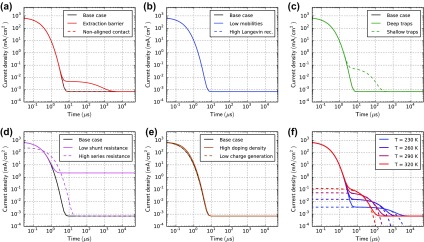
DLTS simulations for all cases in Table 1. The voltage is 0 V for t < 0. At t = 0 the voltage jumps to −5 V. (f) DLTS simulations of case ‘shallow traps’ at different temperatures (solid lines). The dashed lines are exponential fits according to Equation (14).